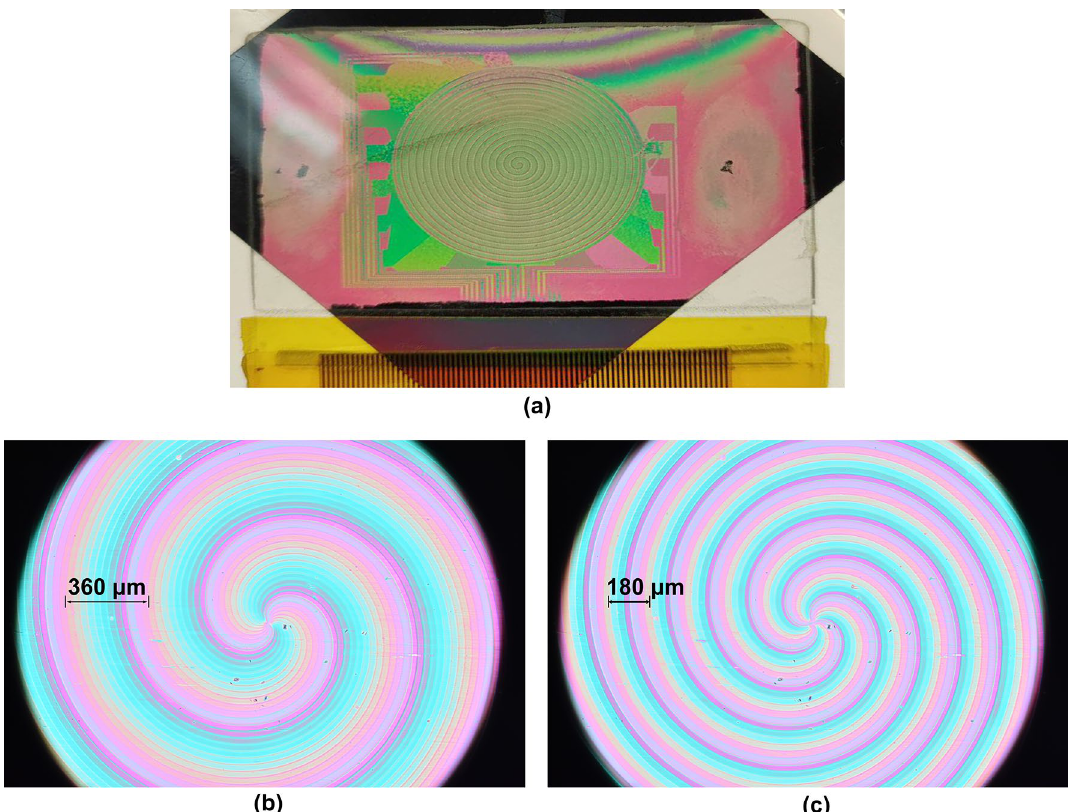
Figure 4. On top ( a ), the developed device. On the bottom, micrographs showing two different DSA configurations between crossed polarizers in white light illumination. ( b ) l = 2 ( (cid:31) = 360 µ m ). ( c ) l = 4 ( � = 180 µ m